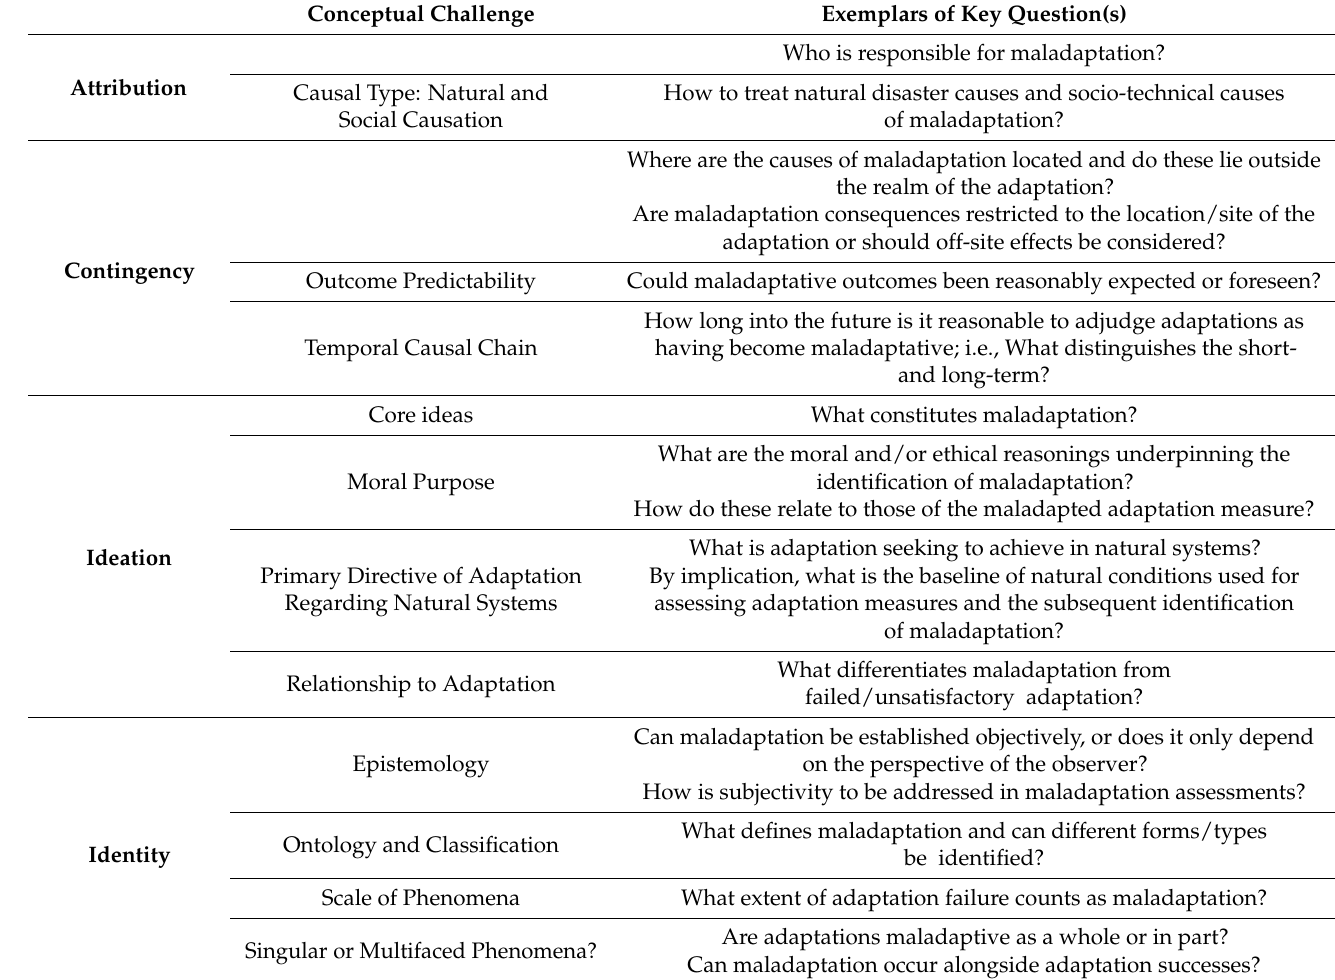
Table 1. Key Conceptual Challenges in